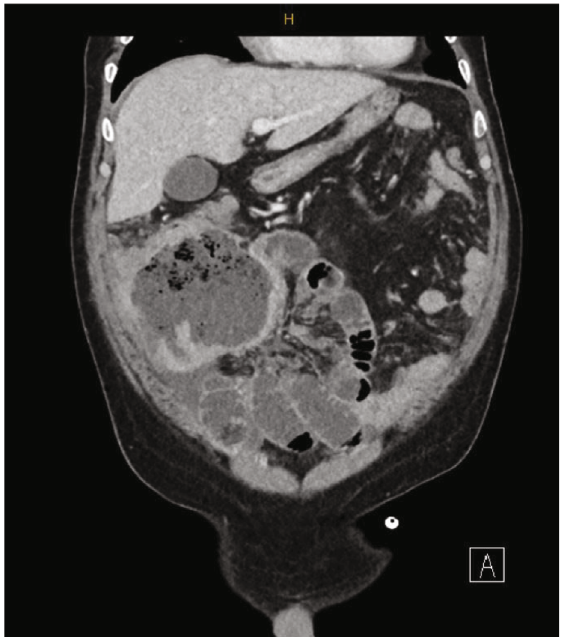
Figure 1: Pre-operative coronal CT images demonstrating the faecaloma.